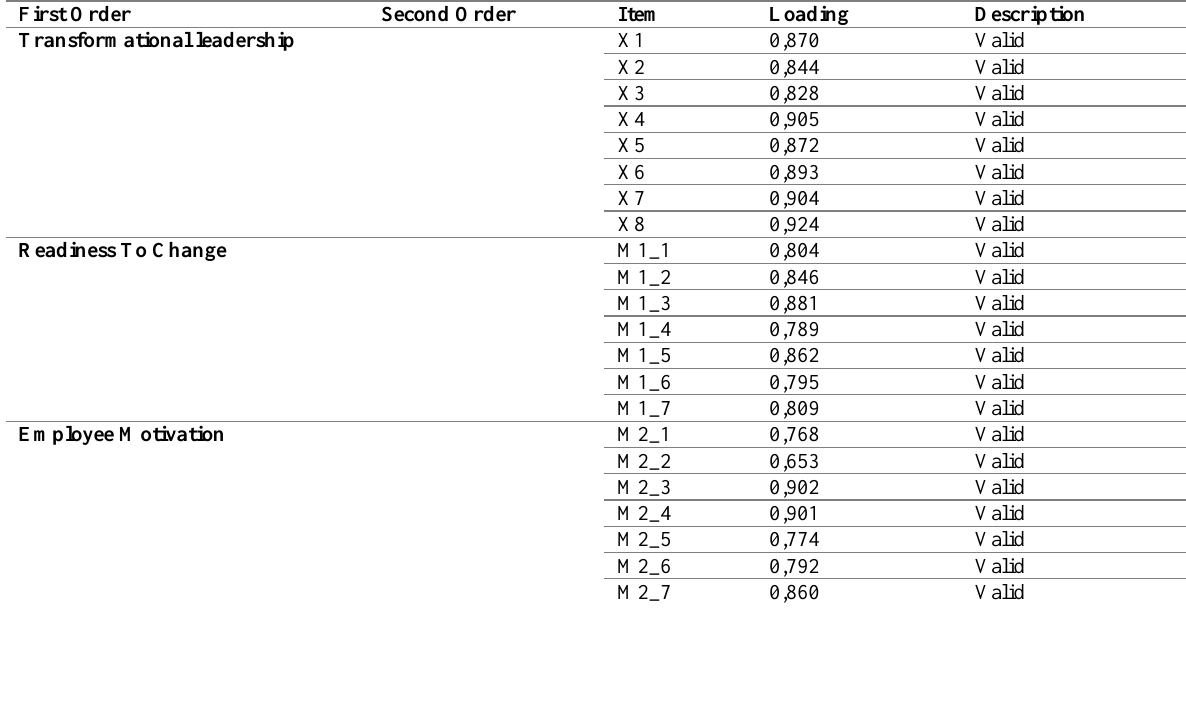
Table 2: Construct loading factor